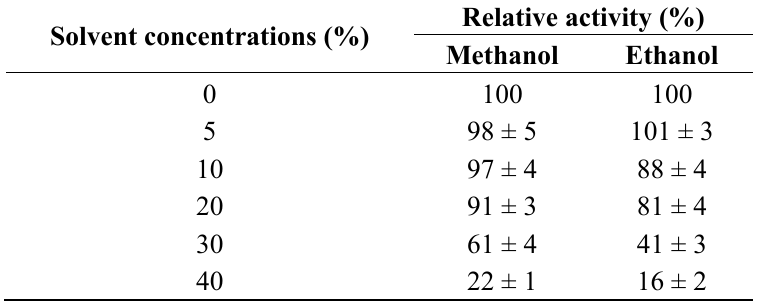
Table 4. Influence of methanol and ethanol concentrations on the activity of rProROL. Enzyme samples were incubated with various concentrations of methanol and ethanol for 6 h in a shaker set at 160 rpm and 25 °C. The activity was measured with a pH-stat (Metrohm) and using olive oil as substrate at pH 9.0, 40 °C. All measurements were carried out in